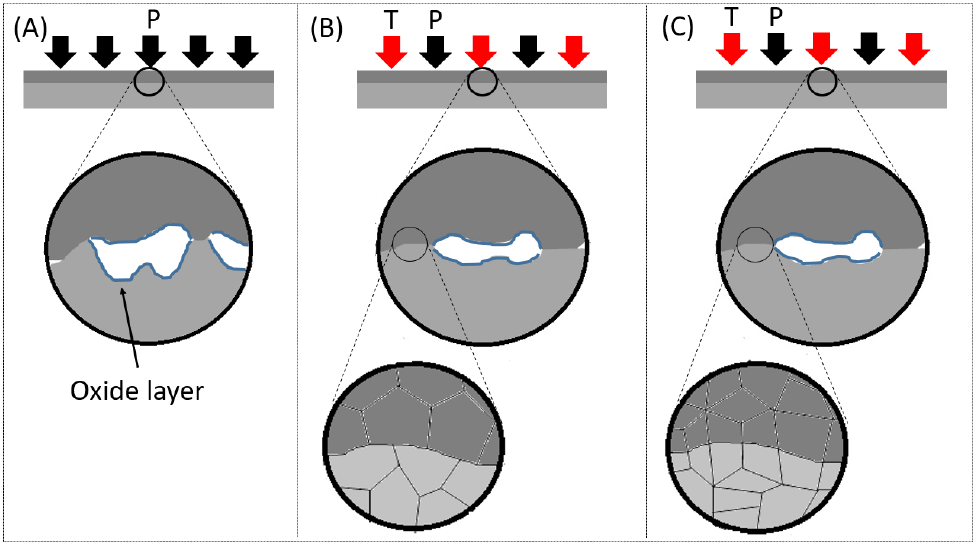
Figure 1. The three different stages of a diffusion bonding process: Initial static pressure ( A ), Heating of the component to the bonding temperature ( B ), Holding at the bonding temperature ( C ).